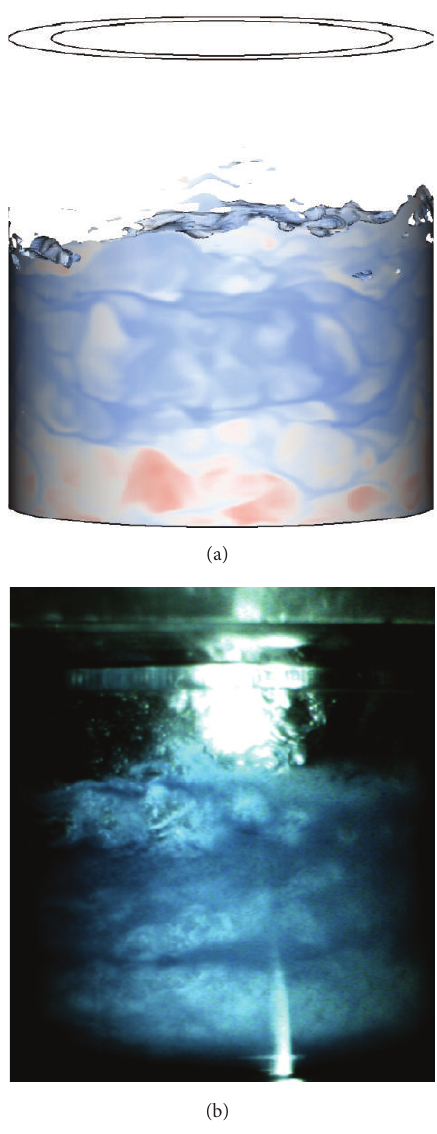
Figure 13: Comparison of snapshots from CFD simulation (a) of 3D annular mixer (fine mesh) and experiment [11] (b) in an actual CINC-V2 centrifugal contactor at a comparable overall liquid height showing similar aqueous phase (blue)